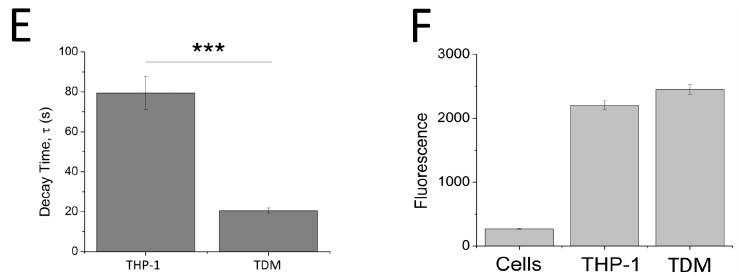
Figure 2. ATP-evoked intracellular Ca 2+ responses in THP-1 monocytes and THP-1 differentiated macrophages. Concentration response curve of ATP (0.01–1000 μ M) in the presence and absence of